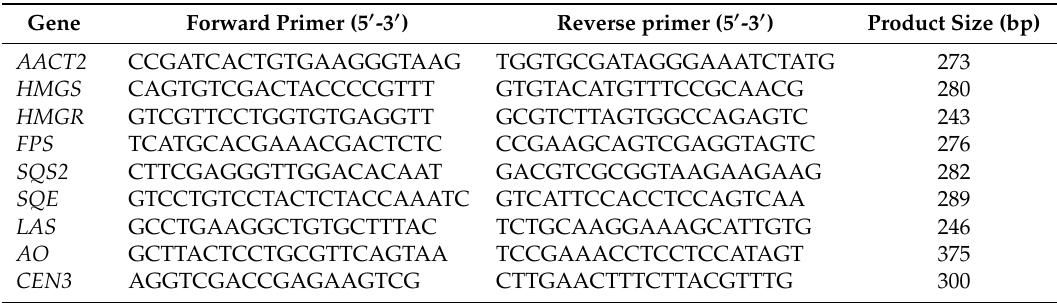
Table 4. Primers used for qRT-PCR validation of gene